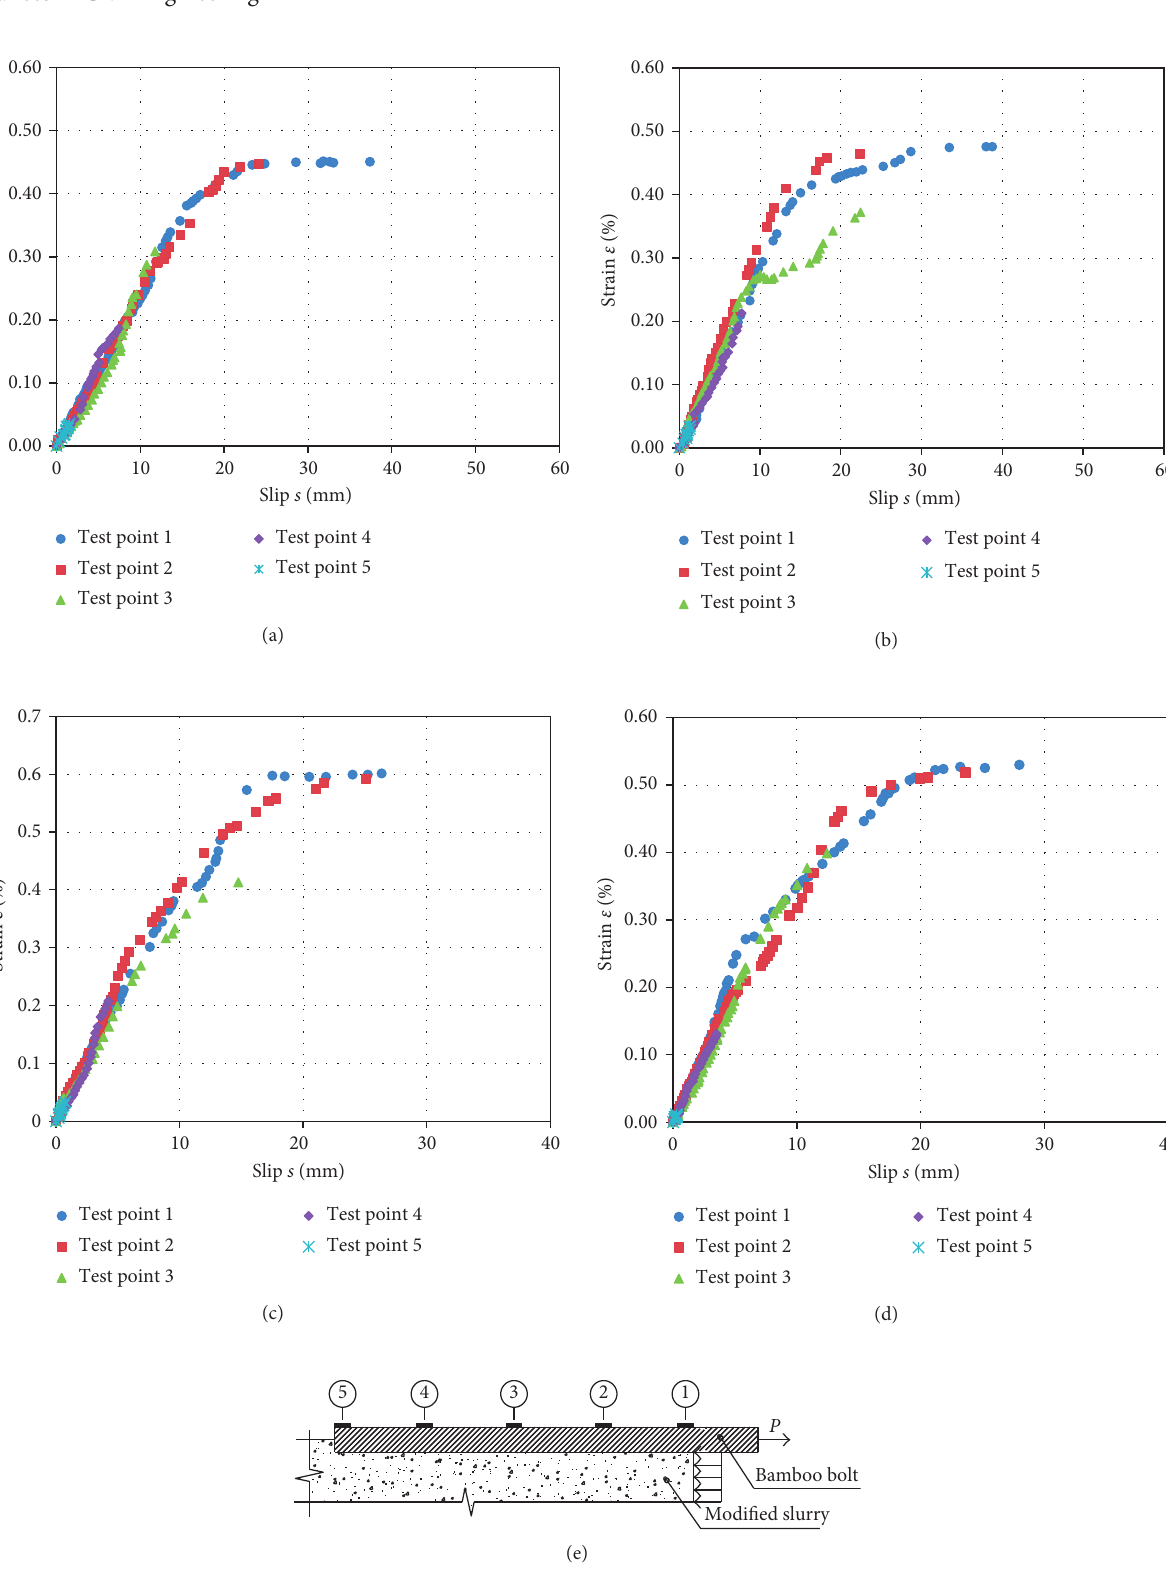
b ≥ L eff ). (a) CB-L-2000a. (b) CB-L-2000b. (c) CB-L-